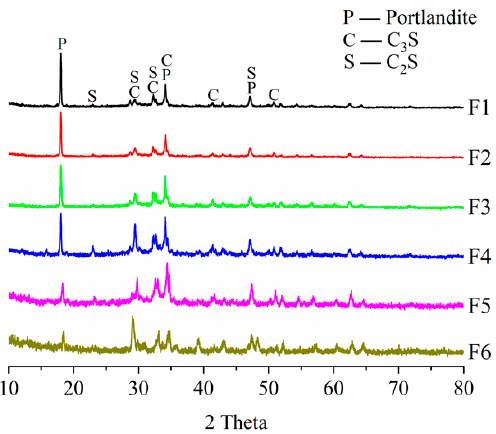
Figure 12. XRD analysis for the cement pastes before self-healing.